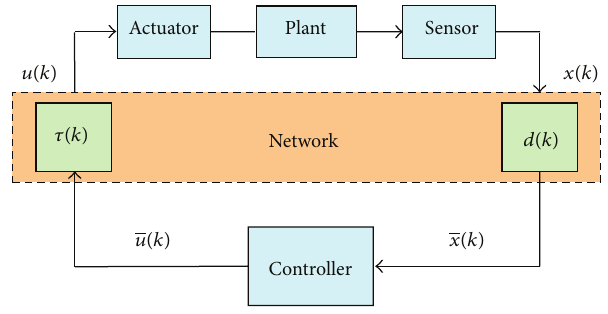
Figure 1: Diagram of a NCS with time